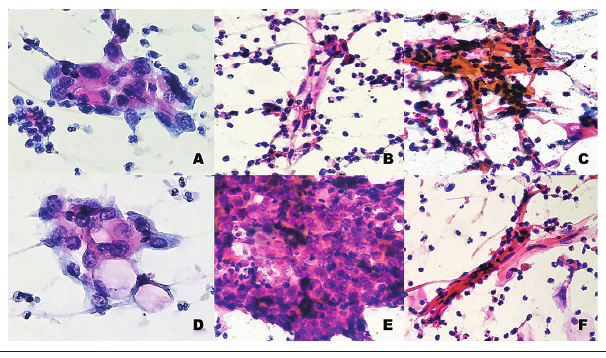
FigurE 2 − Squamous cell carcinoma A) parabasal squamous epithelial cells with karyomegaly, anisokaryosis, changes in the nuclear shape and contour, coarse and irregularly distributed chromatin; B) pleomorphic, fusiform squamous cells, orangeophilic cytoplasm, hyperchromatic nuclei, coarse and irregularly distributed chromatin; C) spindle cells, orangeophilic and hyperchromatic nuclei; D) parabasal squamous epithelial cells with changes in the nuclear contour and coarse and irregularly distributed chromatin; E) syncytia of parabasal squamous epithelial cells with nuclear dyskaryosis; F) orangeophilic, fusiform cells and hyperchromatic and elongated nuclei (magnification 400×).